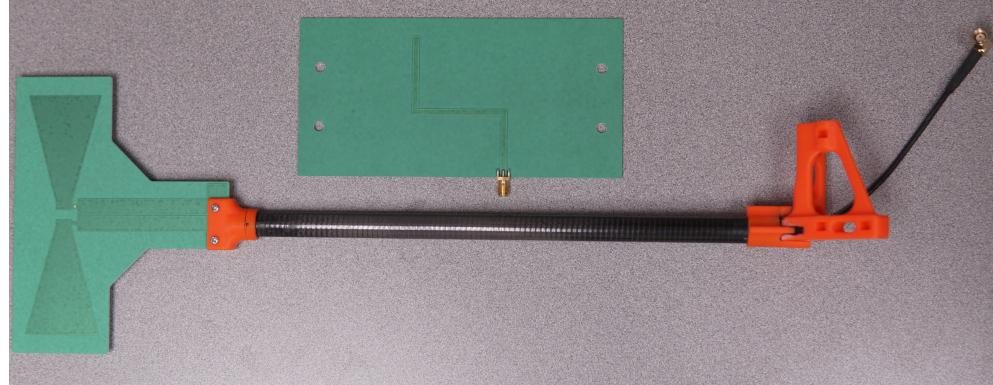
Figure 10. PCB omni-directional antenna, carbon fiber mounting rod, and plastic mounting brackets.